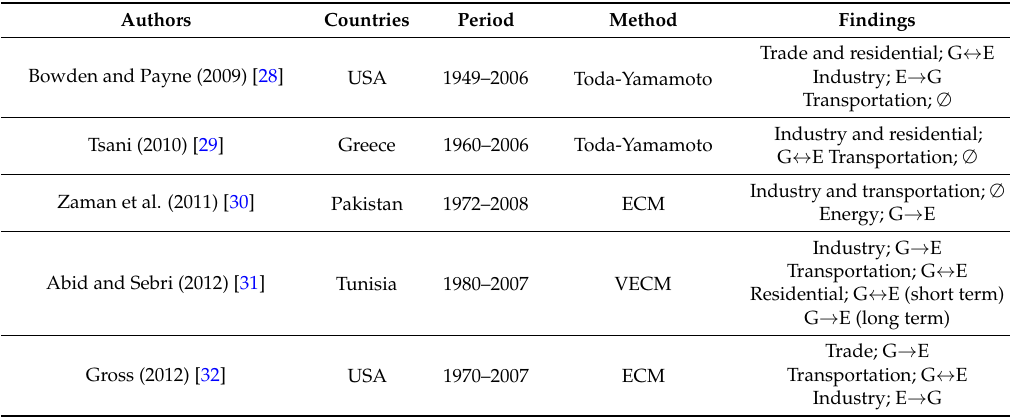
Table 2. Literature of growth-sectoral energy consumption nexus based on